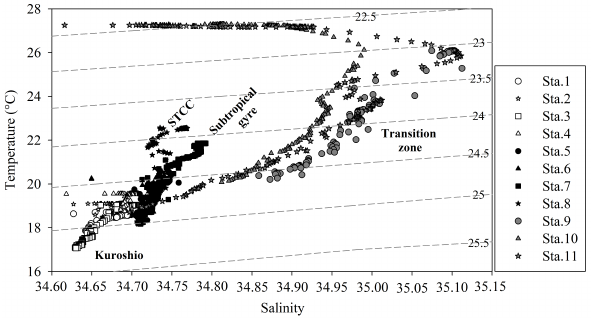
Fig. 5. Temperature-salinity diagram from surface to 200m between stations 1 and 11. The three groups of stations are shown with dif- ferent colours: stations in the Kuroshio region (1–4) by a white sym- bol; stations in the centre of the subtropical gyre (5–8) in black; and stations in the transition zone (9–11) in dark grey.